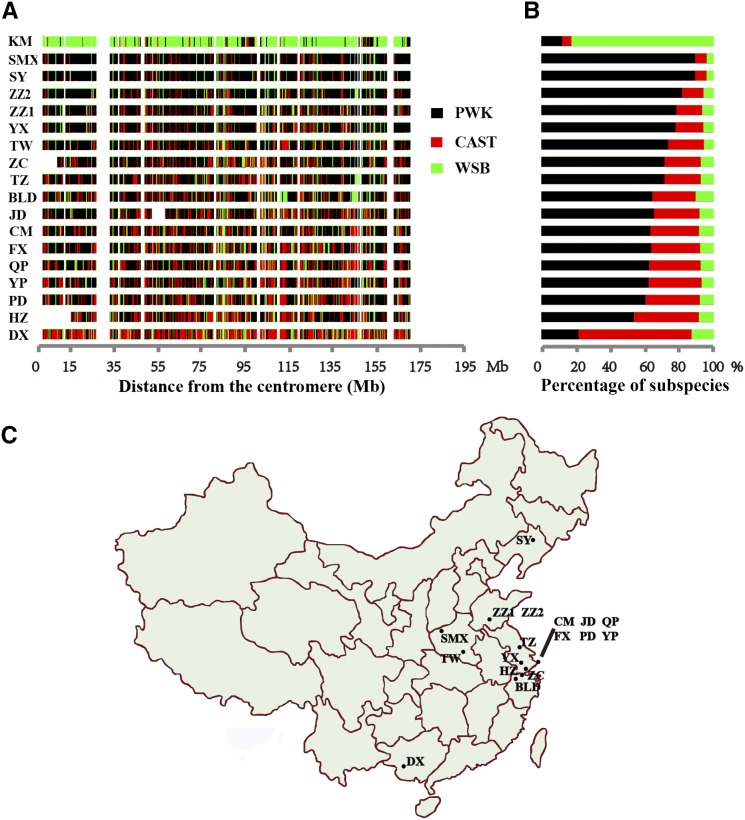
Subspecies origin of Chr 1 of C1SLs. (A) Subspecies assignments for the 18 donor chromosomes. Each 10-kb interval is shown as a vertical bar of a color that reflects its subspecies origin. Intervals without color are regions of intersubspecies introgression or of undetermined status. (B) Contribution of the three main subspecies lineages in Chr 1 of C1SLs. (C) Wild mice collection sites in China.